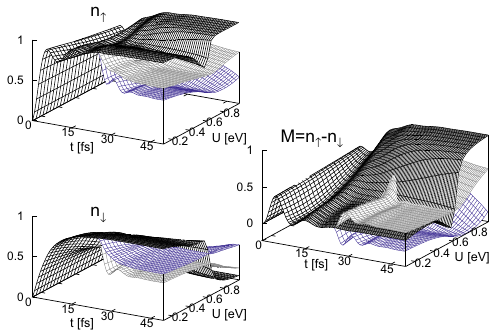
Fig. 5. . Island level occupancies and island magnetization as a function of time and of the Coulomb integral (Hubbard U). Dark grey surface: Only the left lead is turned on (cf. Fig. 3). Light grey surface: Right lead turned on at 25 fs, parallel magnetization of the leads. Blue surface: Right lead turned on at 25 fs, anti-parallel magnetization of the